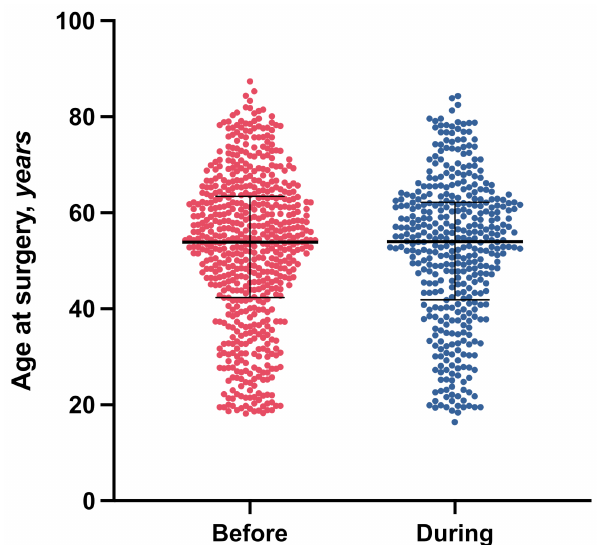
Figure 1. Age distribution. Bars represent medians and interquartile ranges.